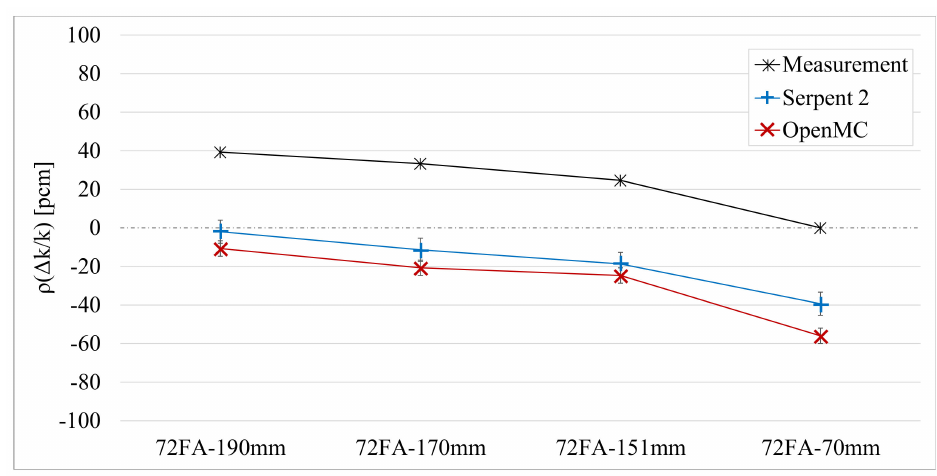
Figure 3. Results of